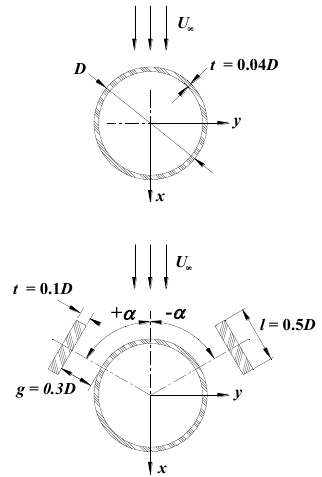
Fig. 1. Cross-sectional view of the circular cylinder without (upper one) and with guiding